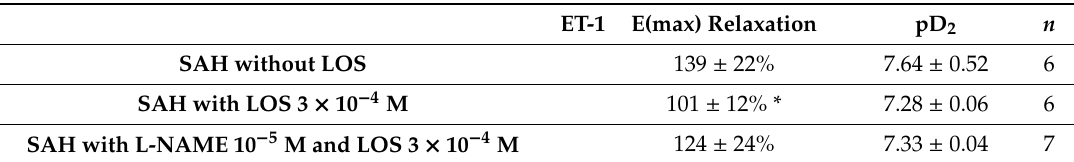
Table 3. Contractile assessment (ET-1) after preincubation with L-NAME and LOS, as well as after preincubation with and without LOS only under pathophysiological conditions after subarachnoid haemorrhage. ET-1 induced a dose-dependent contraction, which was significantly reduced under LOS. This LOS-dependent e ff ect was less pronounced after prior NO inhibition through L-NAME. Values are expressed as mean ± SD. * p < 0.05 versus without LOS.